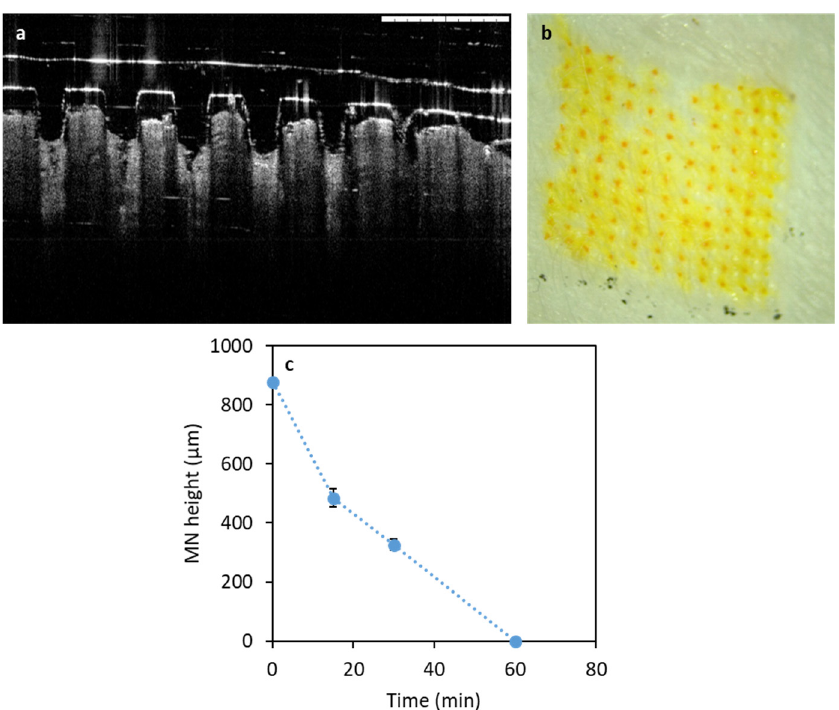
Figure 7. ( a ) OCT of CU-NS MN in ex vivo neonatal porcine skin (Scale bar = 1 mm); ( b ) Light microscope of CU-MN treated neonatal porcine skin and ( c ) CU-MN height versus time after insertion into porcine skin. Means ± S.D., n = 3.